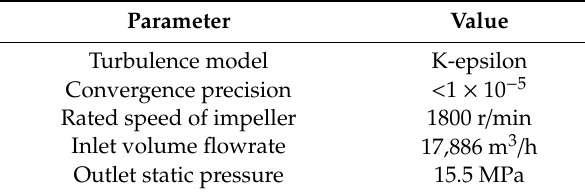
Figure 3. Mesh diagram of the model (( a ) Inlet pipe ( b ) Impeller ( c ) Vane diffuser ( d ) Volute). Table 2. Impeller simulation settings.